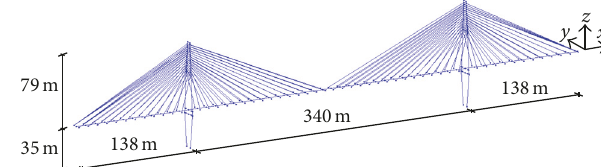
Figure 15: Finite element model of the Skytrain